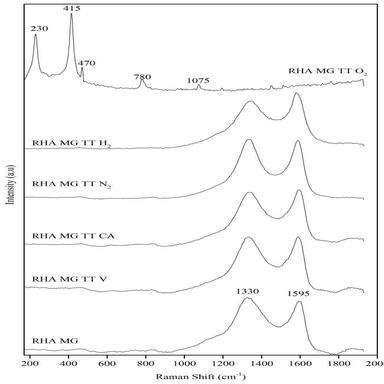
Raman spectroscopy of the different heat treatments performed for RHA MG.